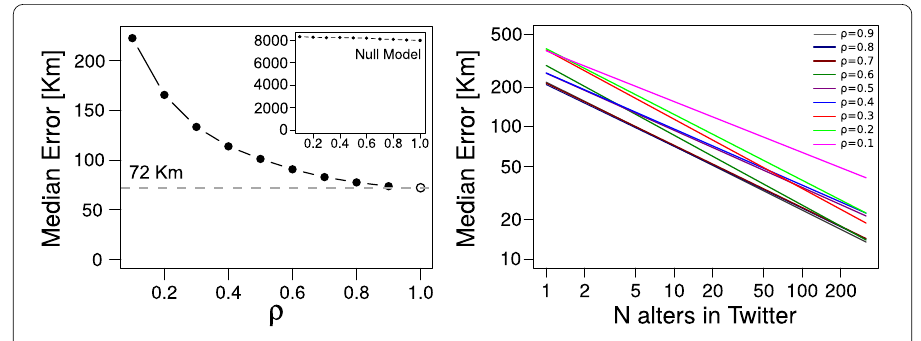
Figure 4 Location prediction quality as a function of disclosure tendency and number of friends. The left panel shows the median error of location prediction in 1000 samples for each value of ρ ∈ [0.1,0.9], with bars showing 95% bootstrapping confidence intervals (not visible). The median error approaches the value of the error when ρ = 1, using all alters, which is 72 Km. The inset shows the error of the Null Model, which is several orders of magnitude larger that the error of shadow profiles. The right panel shows stratified regression lines of median error as a function of the number of alters in the samples, revealing that error decreases with number of alters for the different values of ρ